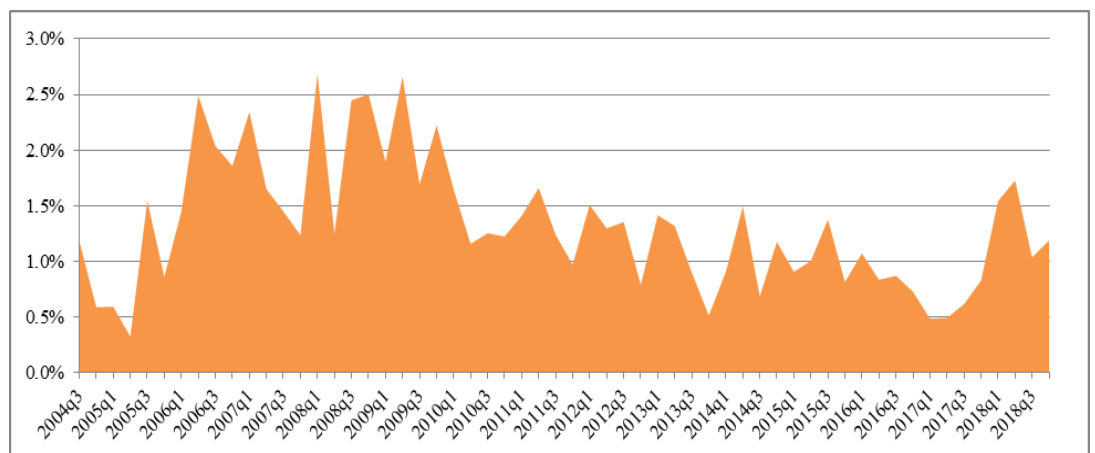
Figure 5. Stock market volatility in Vietnam